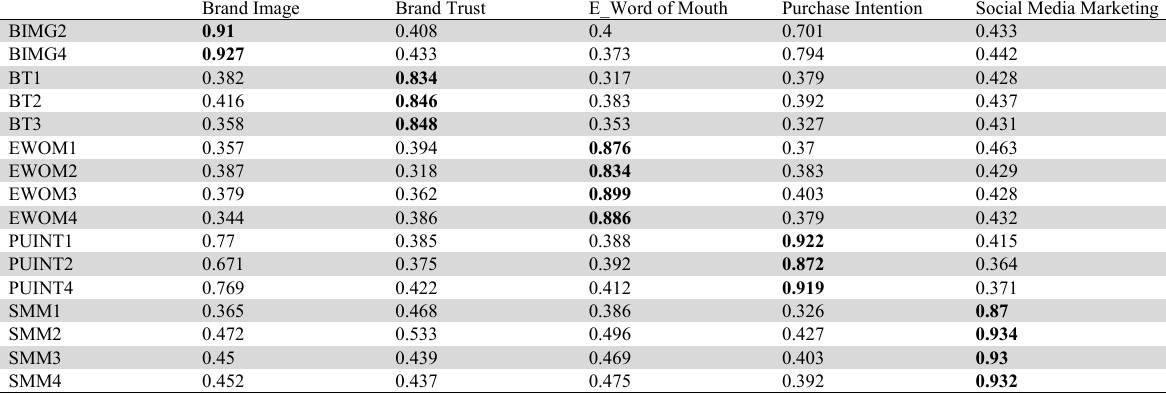
The results of Cross-loadings